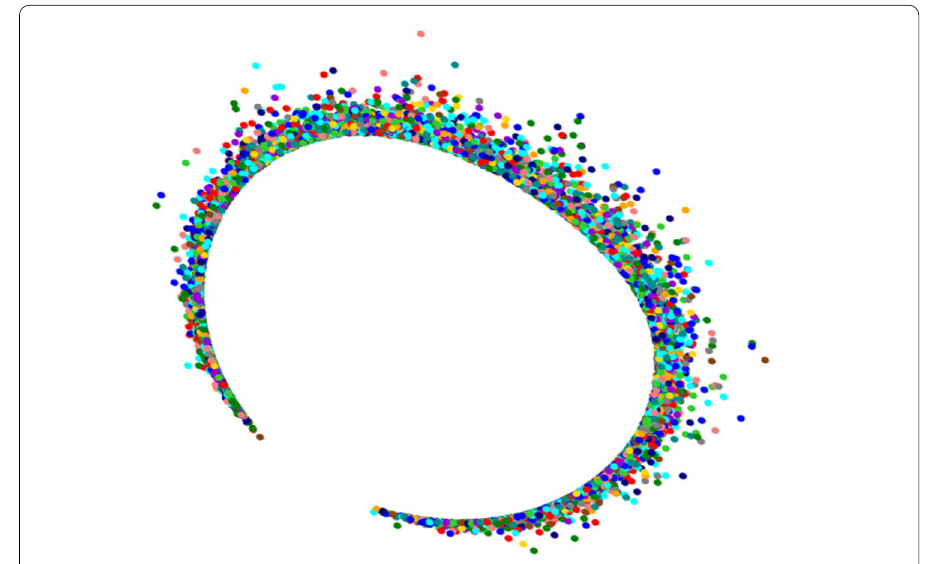
Fig. 14 Temperature-based clustering results visualized on the MDS plot of the dissimilarity matrix δ